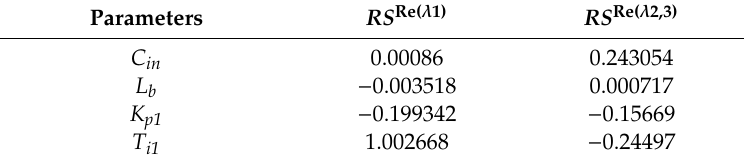
Table 5. Converter parameters.